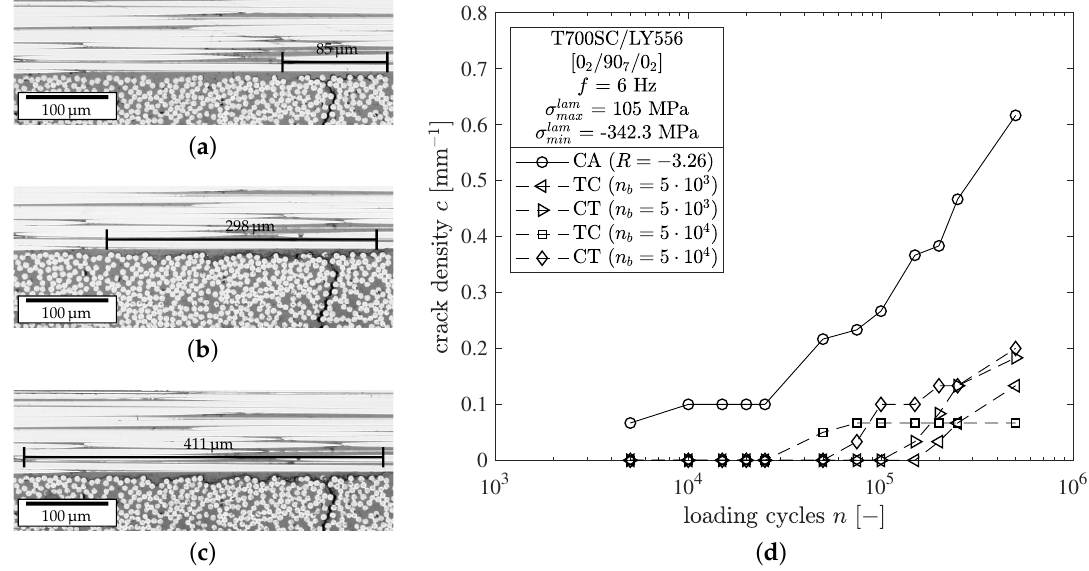
Figure 3. Consecutive edge micrographs of a delamination growing from a microcrack at σ lam x = 105 MPa with R = − 3.26 after ( a ) n = 5000, ( b ) n = 15,000 as well as ( c ) n = 25,000 and ( d ) crack density evolution for constant amplitude (CA) and block-loading (TC/CT) experiments.